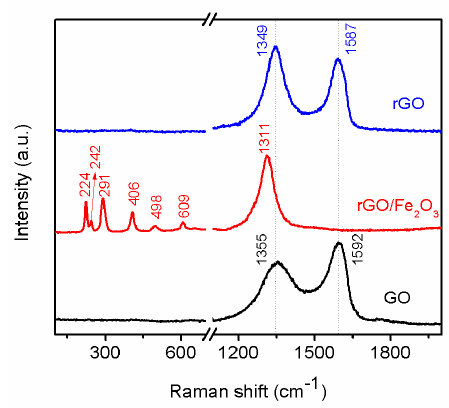
Figure 5. Raman spectra of GO, r-GO/Fe 2 O 3 , and r-GO.